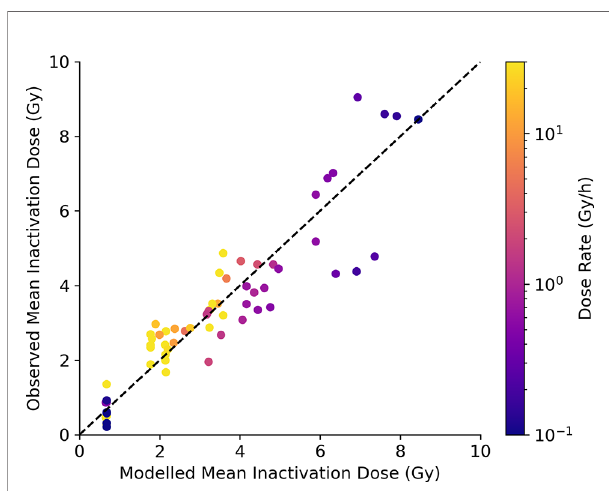
FIGURE 7 | Model predictions of survival at varying dose rate. Modelled MID is compared to observed MID across a range of cell lines and dose rates, with points coloured according to delivered dose rate. Good correlation can be seen, with the increase in radioresistance re fl ected for cells with competent repair, but not for cells with DNA repair defects (bottom left). Best fi tting slope has a slope coef fi cient of 1.0 ± 0.03, with an R 2 of